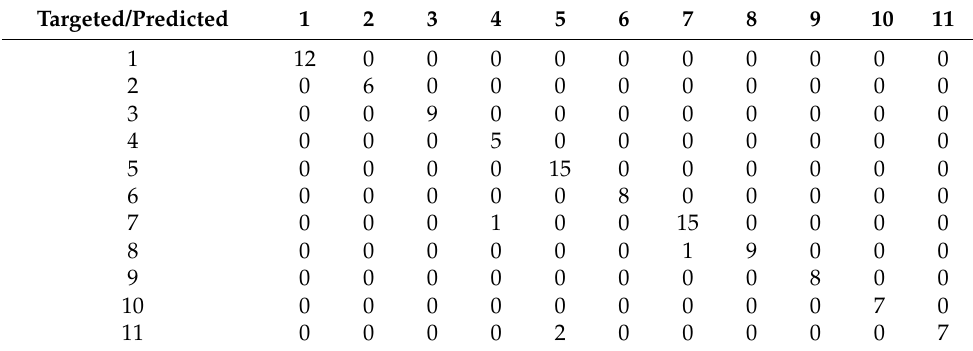
Table 7. The confusion matrix for ConvLSTM architecture.